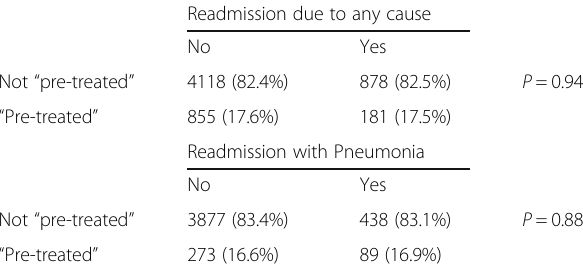
Table 6 The relationship between 30-day readmission and “ pre-treatment ” with